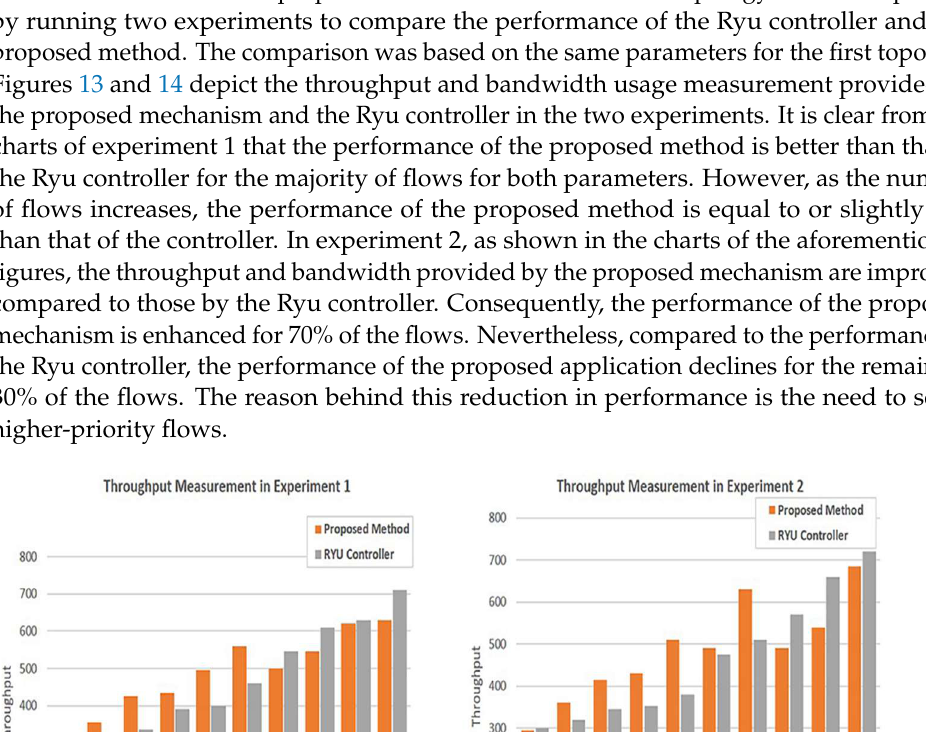
Figure 14. Comparison of Bandwidth Usage Between the Proposed Method and the Ryu Controller for the Two Types of Flows in Two Experiments. In general, it is observed that the performance of the two methods improves as the number of flows increases in both experiments. The third parameter that was used to compare the performance of the proposed ap- proach and the RYU controller is the data transfer rate. This parameter was added to sup- port the evaluation of the proposed method. Figure 15 shows that the proposed method is more effective in transferring data than the Ryu controller for most of the flows in both experiments. Based on the measurement of the rate of data transfer, the proposed method